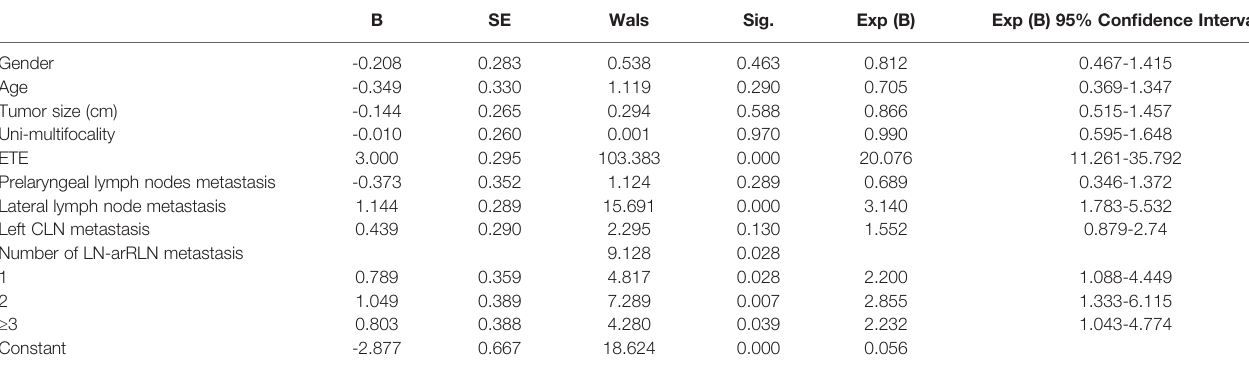
TABLE 6 | Multivariate analysis of clinicopathologic characteristics in LN-prRLN lymph node metastasis.